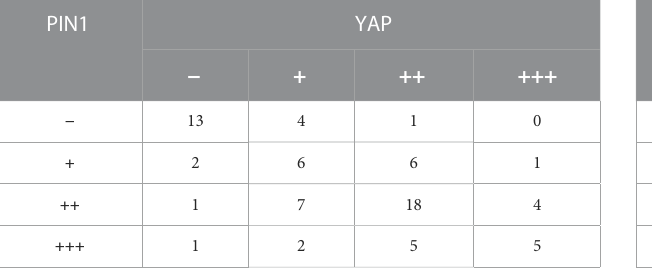
TABLE 1 The correlation of PIN1-YAP was analyzed after IHC results were scored.